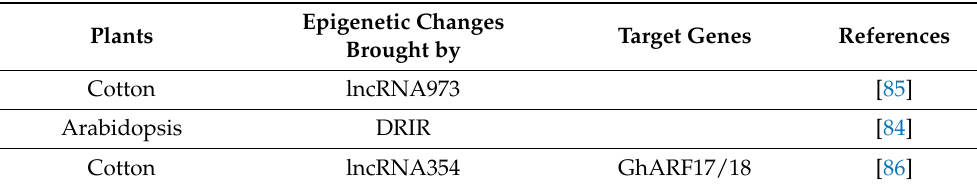
Table 4. lncRNAs mediated epigenetic changes under salinity stress. A summary of recently reported lncRNAs and their targeted genes are enlisted